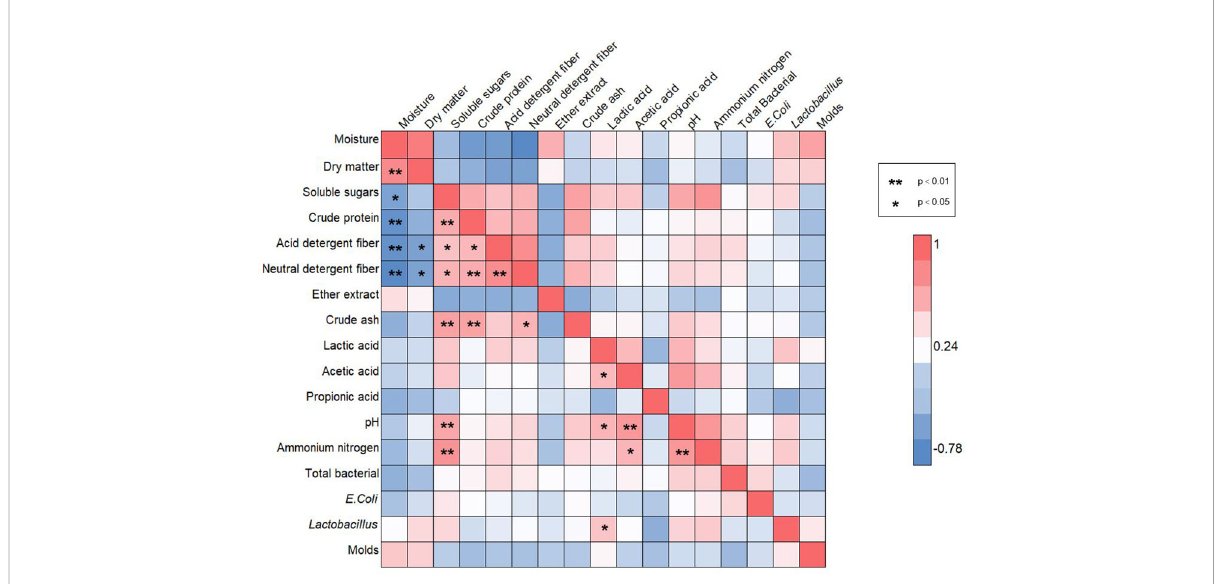
FIGURE 6 Pearson correlation heat map for all chemical components or microorganisms. The “ * ” in the graph indicates a signi fi cant correlation between indicators at the p < 0.05 level, while “ ** ” indicates a signi fi cant correlation between indicators at the p < 0.01 level. In the graph, blue squares represent negative correlations, while red squares represent positive